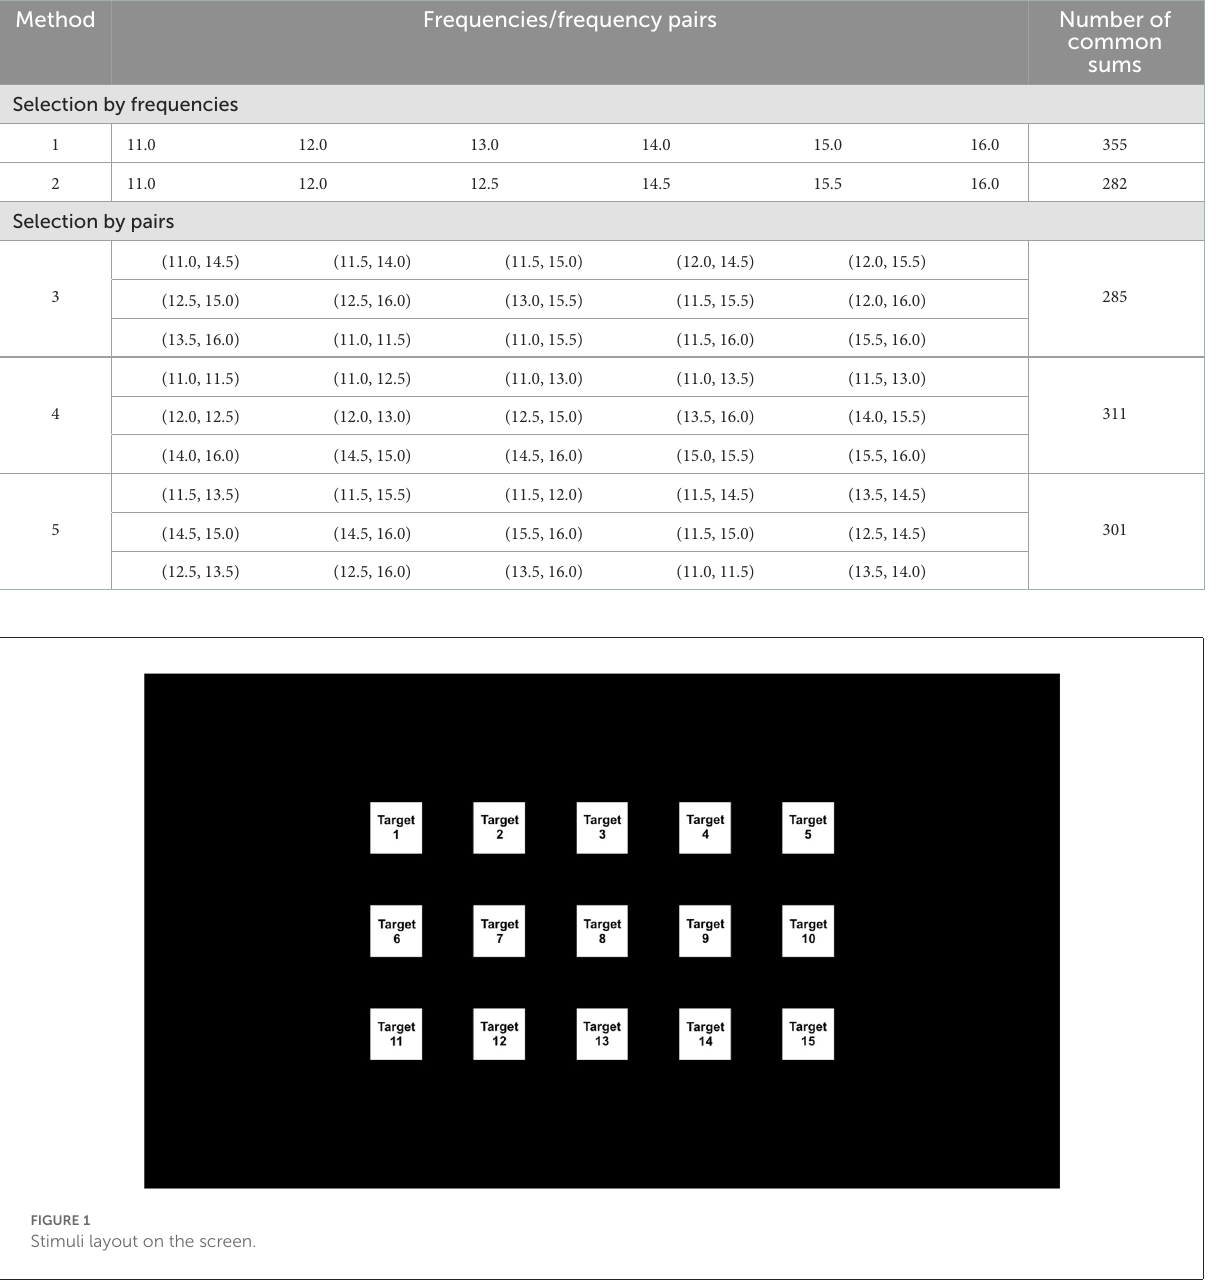
TABLE 3 Frequency sets obtained from optimization and their corresponding number of common sums.